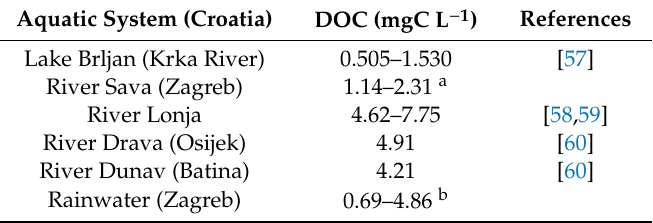
Table 1. Comparison of DOC concentrations between rainwater and natural surface waters in